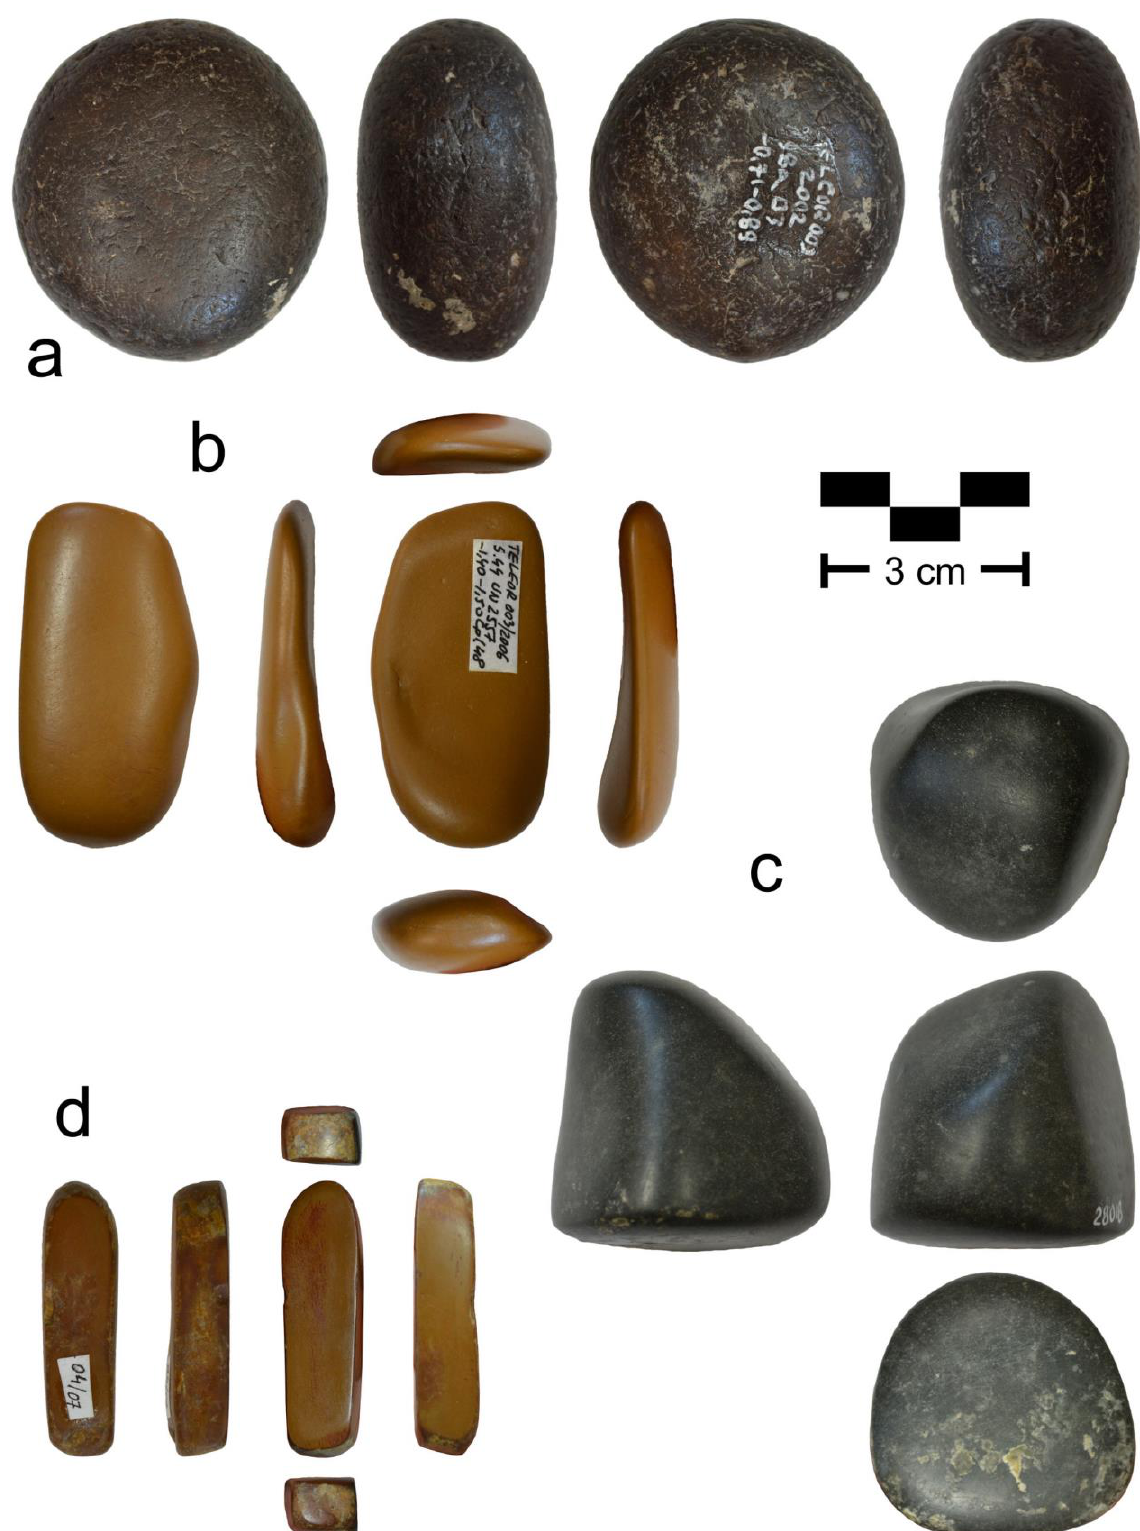
Figure 9. Examples of polishing stones. From a., b., d. Măgura ‘Buduiasca’; c. Vităneşti